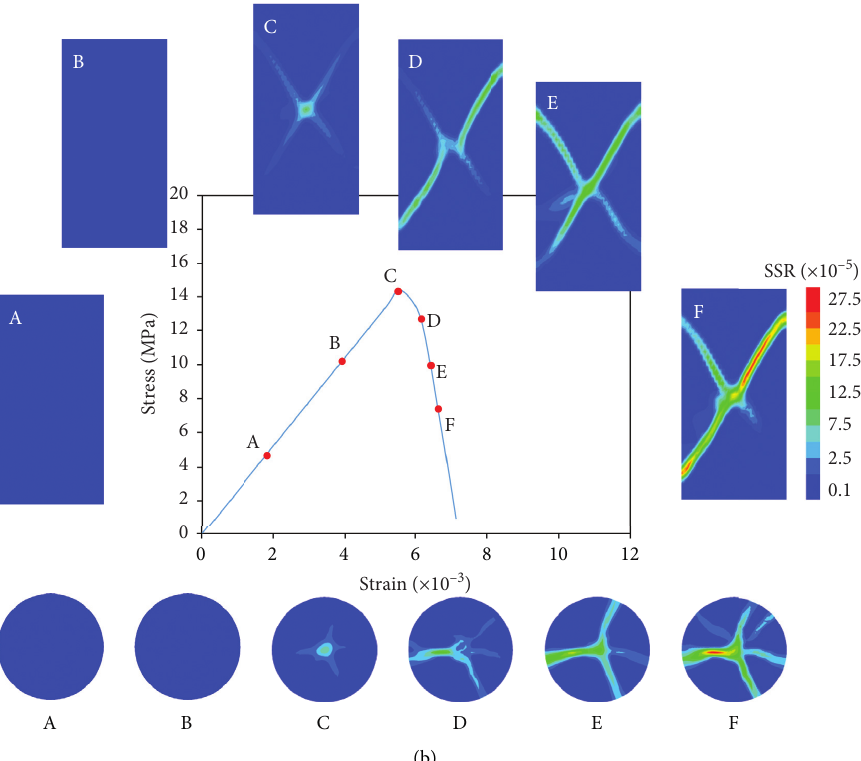
Figure 17: Comparison of model failure pattern between the method of parameter assignment from center to edge and random assignment: (a) assignment from center to edge; (b) random